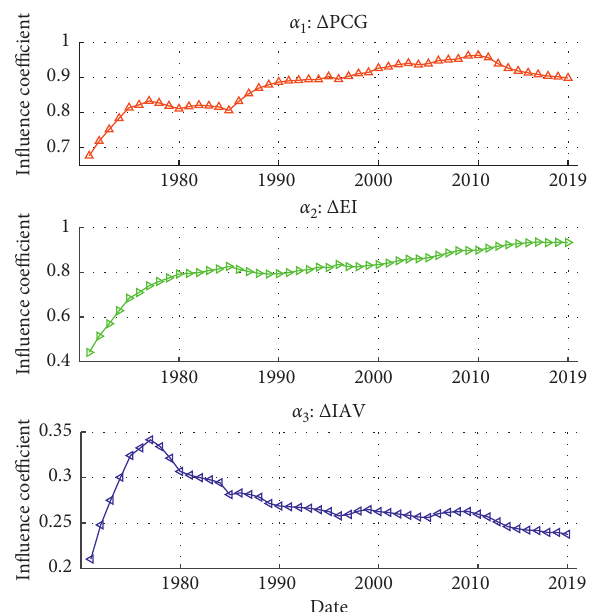
Figure 5: Time-varying coefficient trend diagram of TVP regression model.